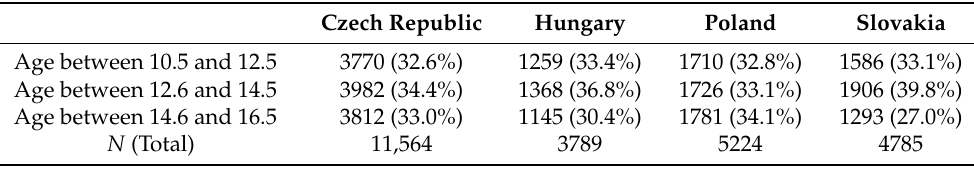
Table 1. Age distribution of the total samples by country.